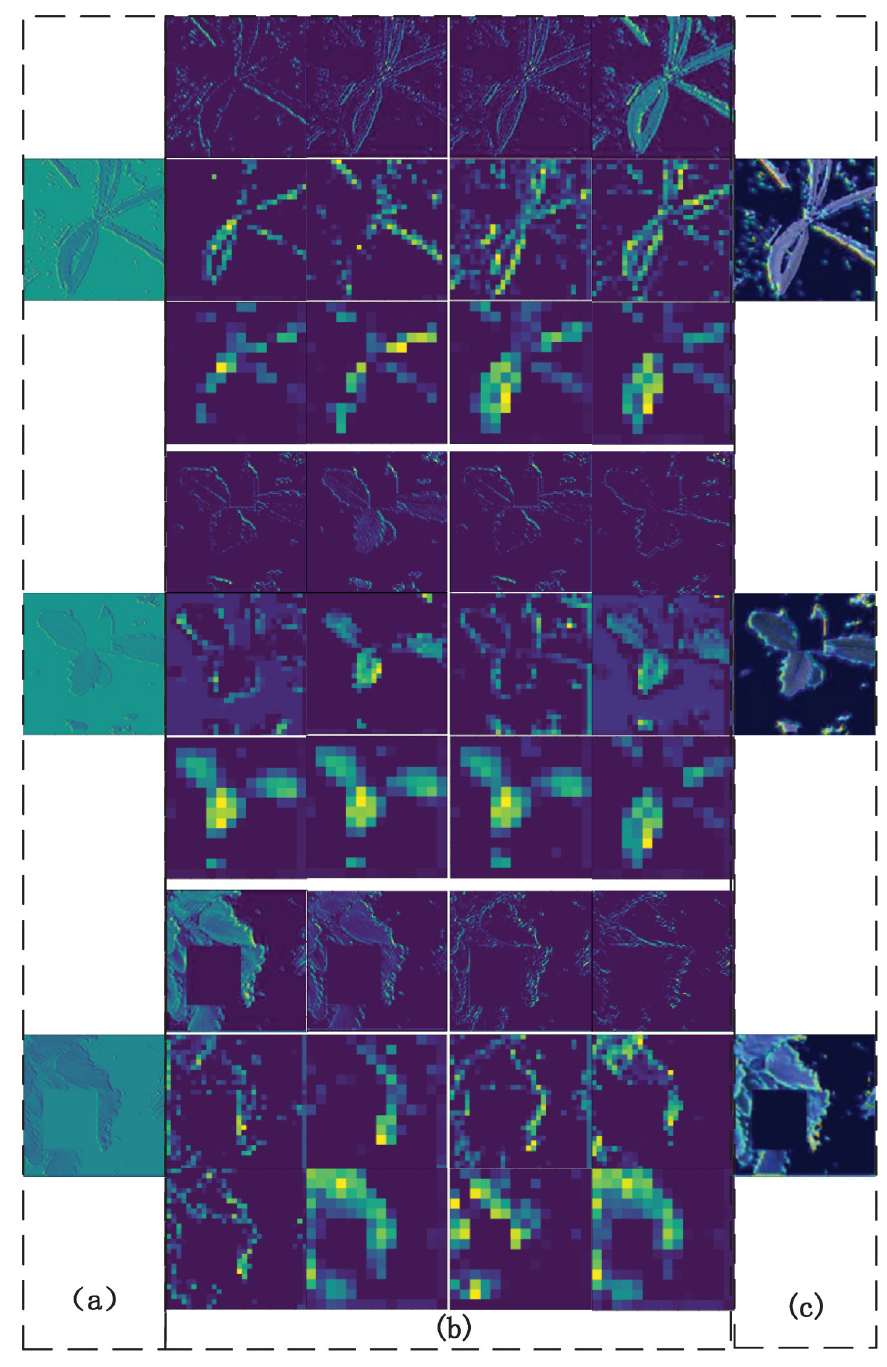
Fig 10. The influence of edge information on model recognition. (a) Feature maps output by a Sobel operator, (b) Feature maps of the first three pooling layers of the network extracted for edges, (c) Extracting network feature map for class-activated